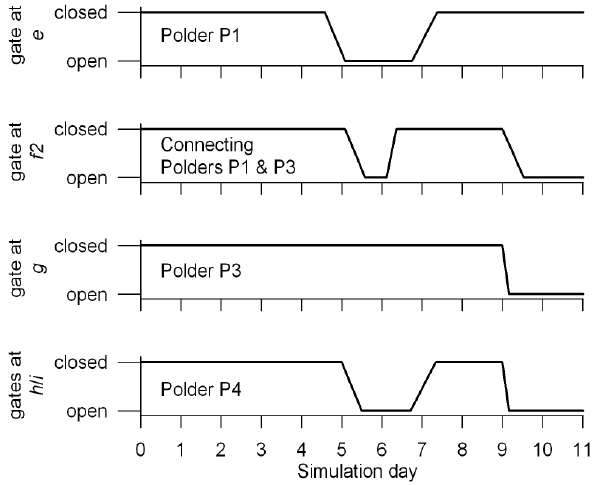
Fig. 5. Optimum control strategy for polder flooding and emptying to cap the peak discharge in the river.